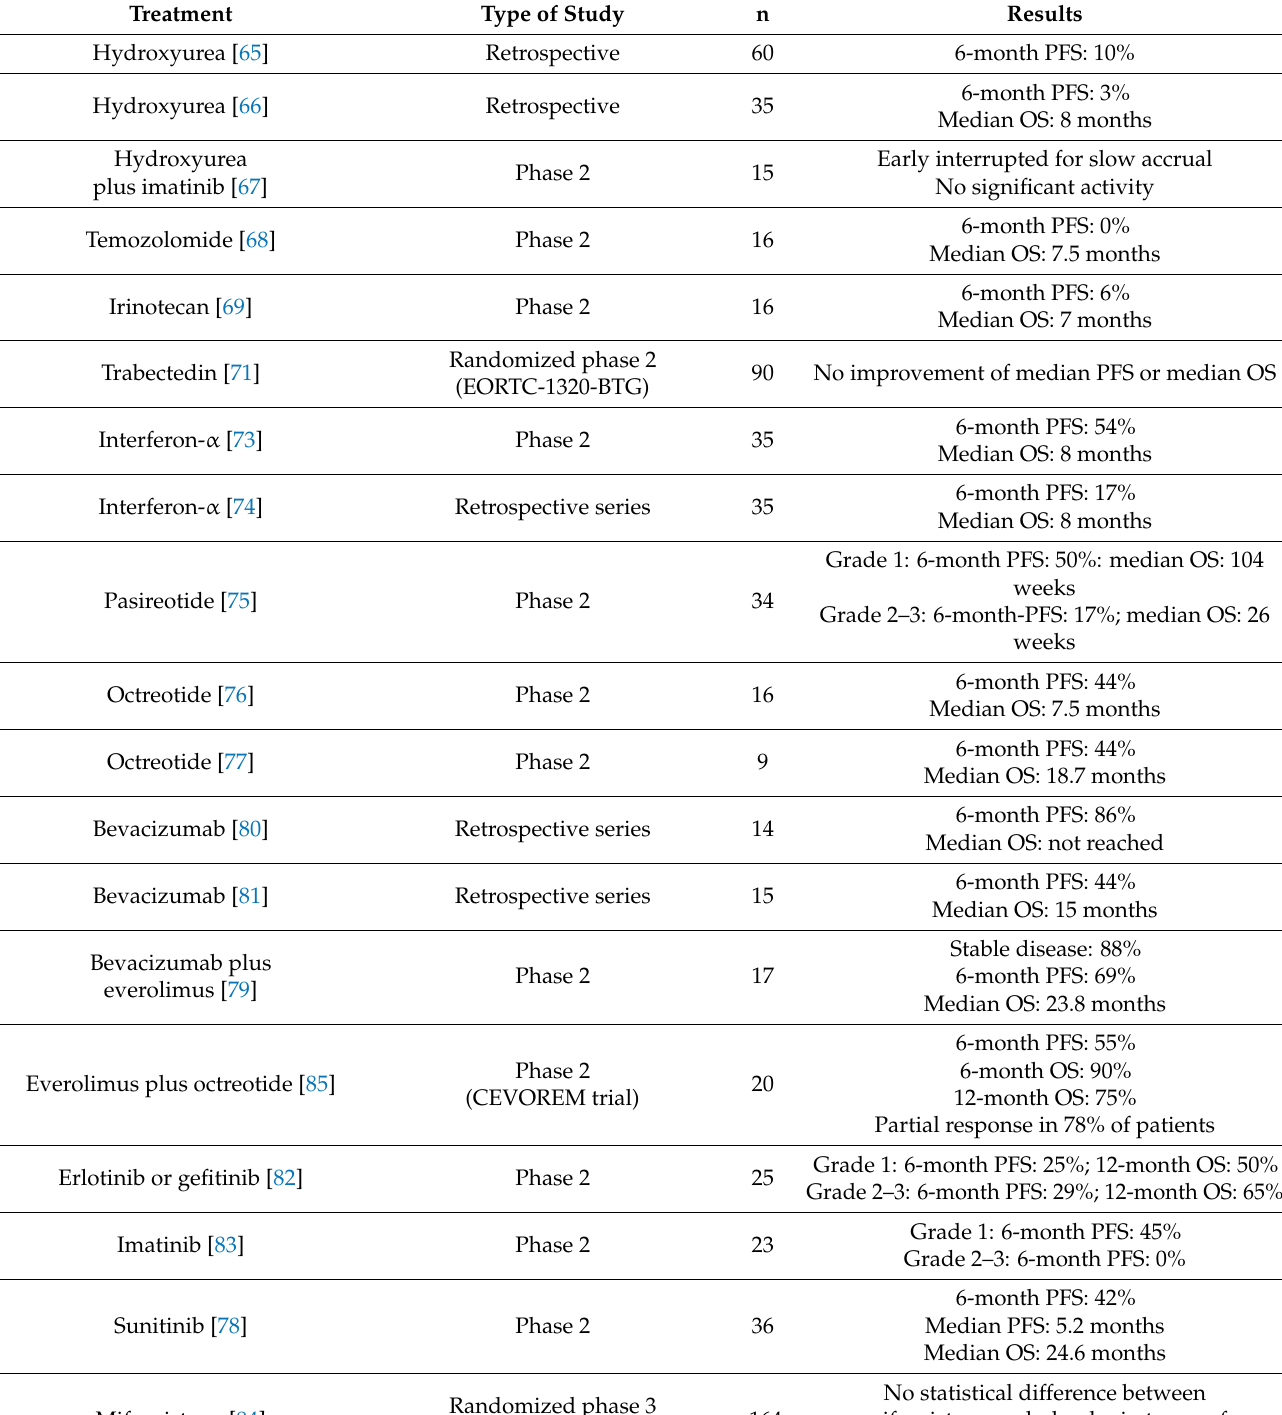
Table 2. Studies of systemic therapies in